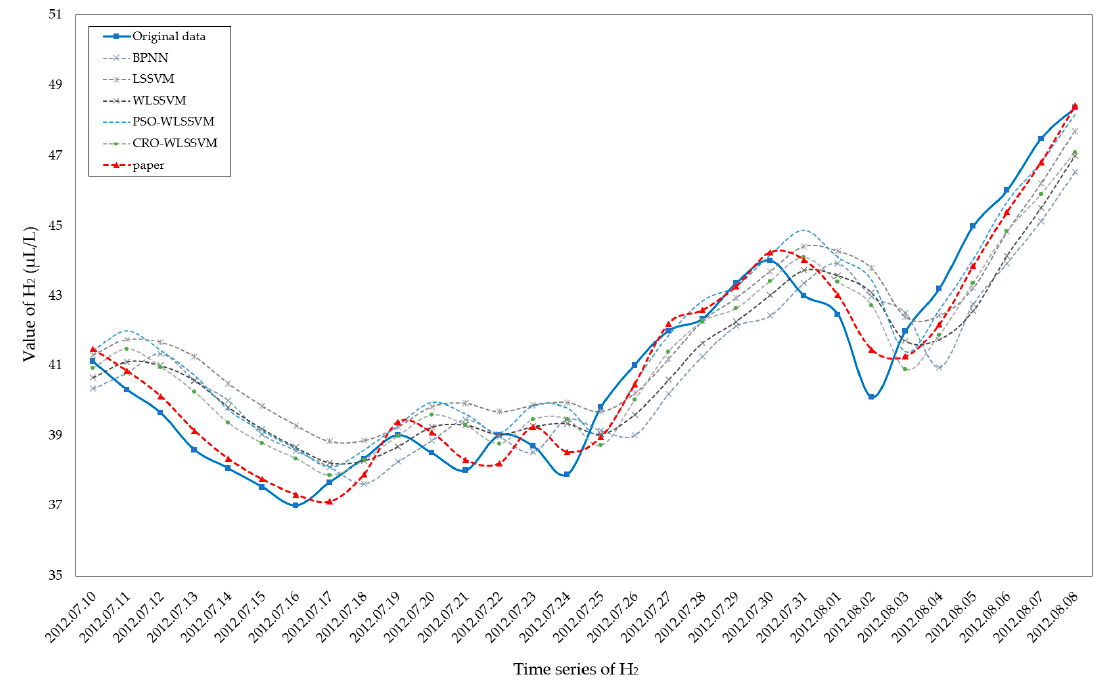
Figure 6. Point forecasting results of six models based on time series of H 2 from 10 July 2012 to 8 August 2012.